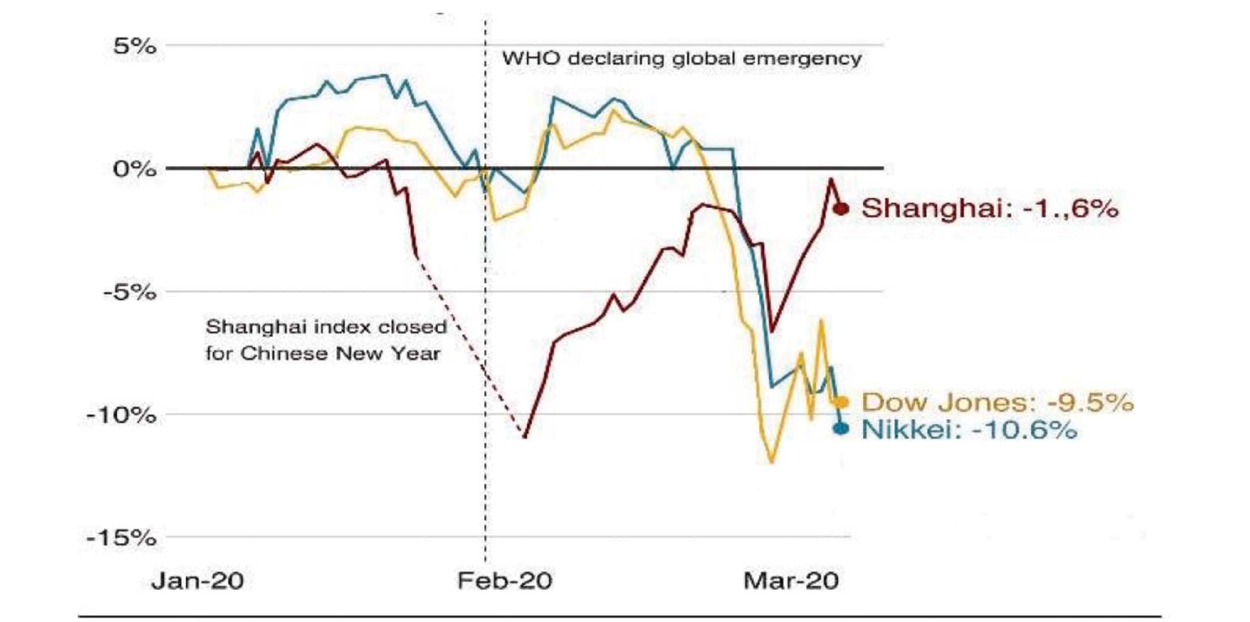
FIGURE 1 | Impact of COVID-19 on stock markets: Source